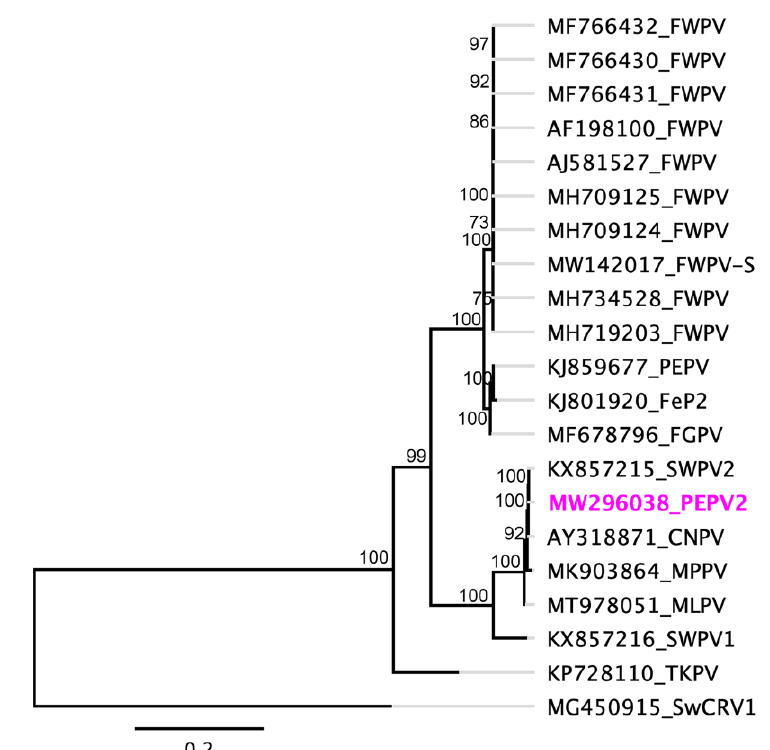
Figure 3. Phylogenetic relationship between PEPV2 and other chordopoxviruses. A maximum likelihood (ML) tree was constructed from multiple alignments of the concatenated amino acid sequences of the selected nine poxvirus core proteins using Geneious (version 10.2.2). The numbers on the left show bootstrap values as percentages. The labels were aligned in the ML tree. The labels at branch tips refer to original ChPV GenBank accession numbers followed by abbreviated species names. The follow- ing abbreviations and GenBank accession details for the selected ChPVs used are: penguinpox virus 2 (PEPV2; MW296038), fowlpox virus standard vaccine strain (FWPV-S; MW142017), canarypox virus (CNPV; AY318871), pigeonpox virus (FeP2; KJ801920), penguinpox virus (PEPV; KJ859677), fowlpox virus (FWPV; AF198100, MF766430-32, MH709124-25, MH719203, MH734528, and AJ581527), fowlpox virus Australian vaccine strain (FWPV-S; MW142017) [48], shearwaterpox virus 1 (SWPV1; KX857216), shearwaterpox virus 2 (SWPV2; KX857215), turkeypox virus (TKPV; NC_028238); flamingopox virus (FGPV; MF678796), magpiepox virus (MPPV; MK903864), and mudlarkpox virus (MLPV; MT978051). Saltwater crocodile poxvirus (SwCRV1; MG450915) [38] was used as an outgroup. The novel PEPV2 is shown in bold font and pink